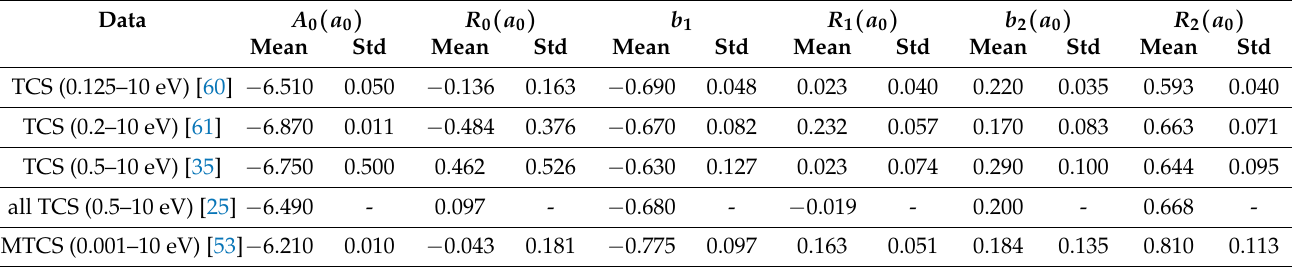
Table 5. Mean values and standard deviations of MERT parameters (appearing in the effective range approximation, Equation (10)) for e − + Xe elastic scattering. The results were calculated using the dipole polarizability α = 27.04 a 3 the effective quadrupole polarizability β = 16.8 a 5 0